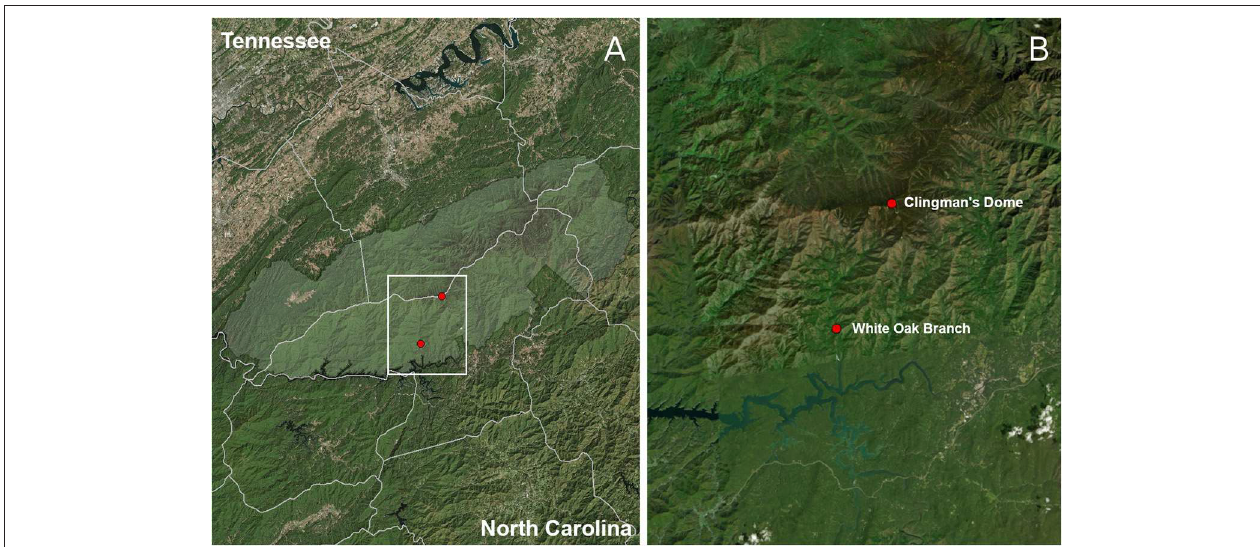
FIGURE 1 | Plot map. Area shaded in light green (A) corresponds to Great Smoky Mountains National Park. White Oak Branch is the low-elevation sampling plot, at 670m elevation, and Clingman’s Dome, the highest peak in Tennessee, is at an elevation of 2,014m (B) .